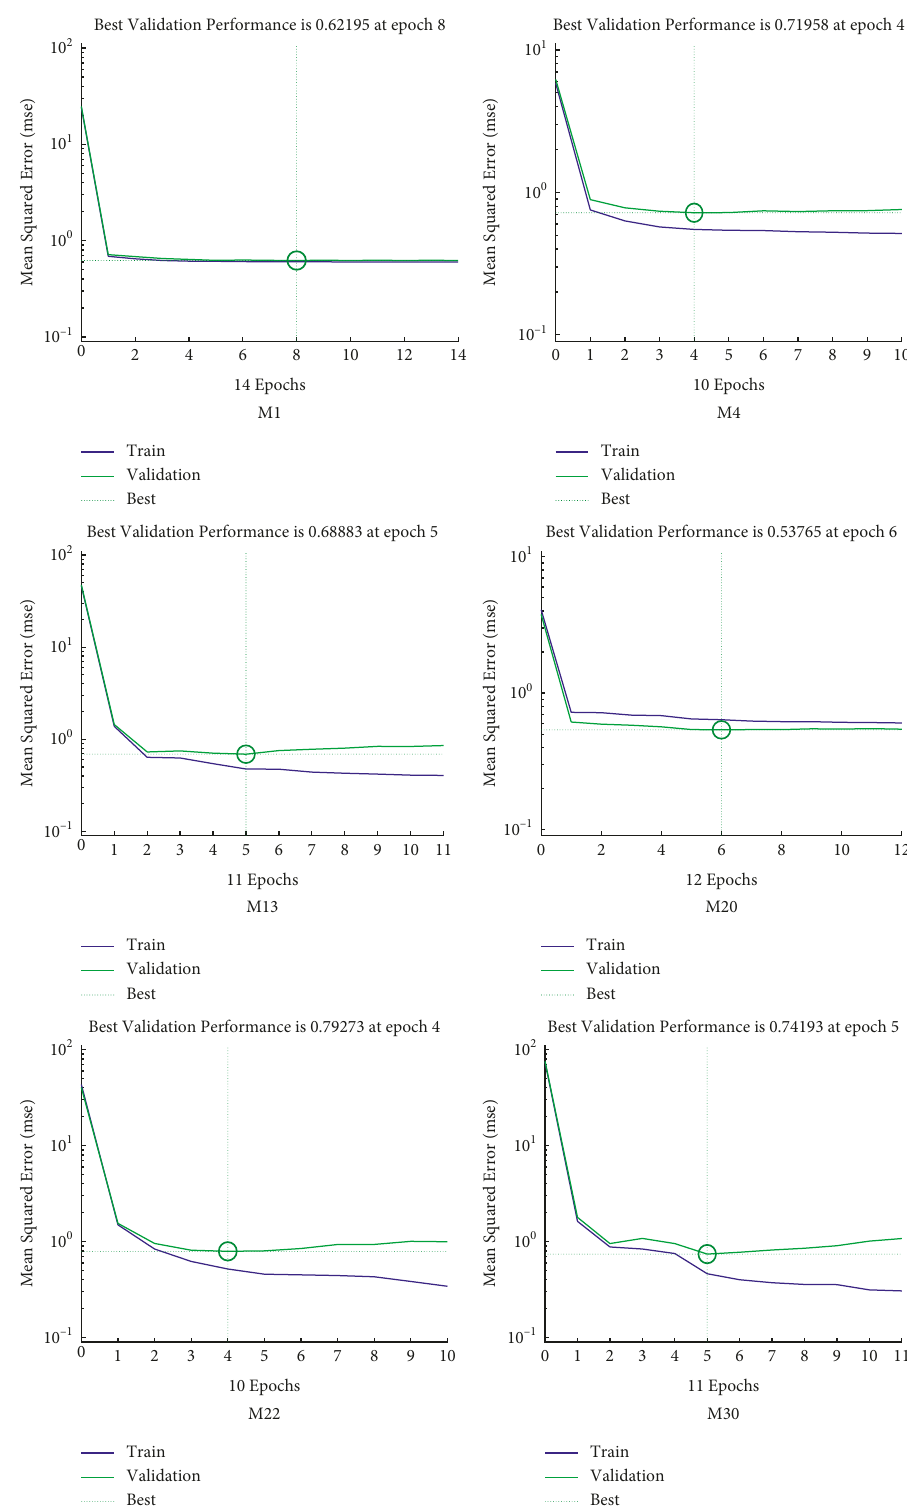
Figure 15: MSE versus epoch curve for best six